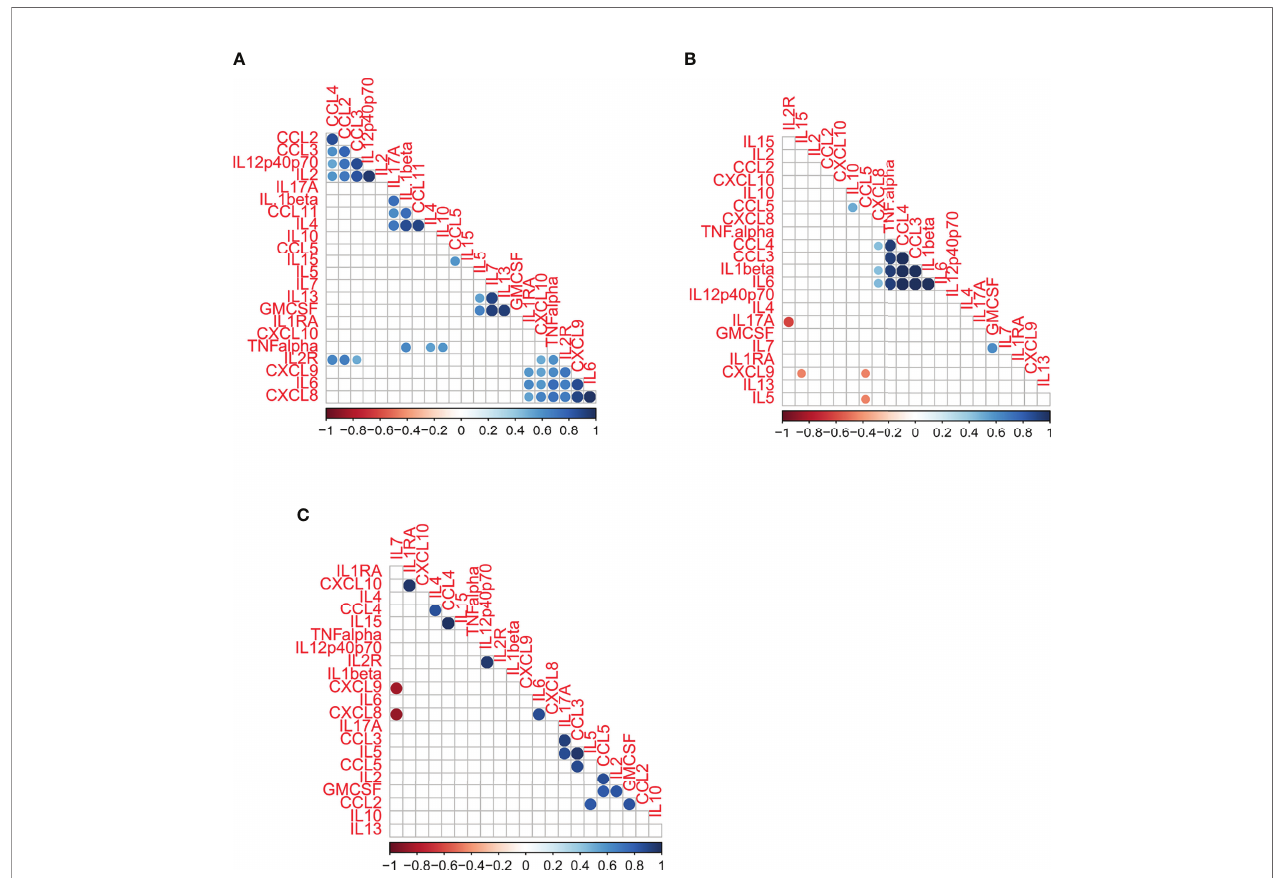
FIGURE 3 | A correlation matrix/correlogram describing distinct patterns of immunological interactions of cytokines in children with (A) Clinical malaria (B) Sepsis and (C) Febrile controls. The matrix displays a Spearman ’ s rank correlation coef fi cient with signi fi cant association (p < 0.05) depicted by a coloured dot/circle. Non- signi fi cant correlations are depicted by empty squares. The strength of the association is indicated by the colour schemes ranging from -1 to 1 in each fi